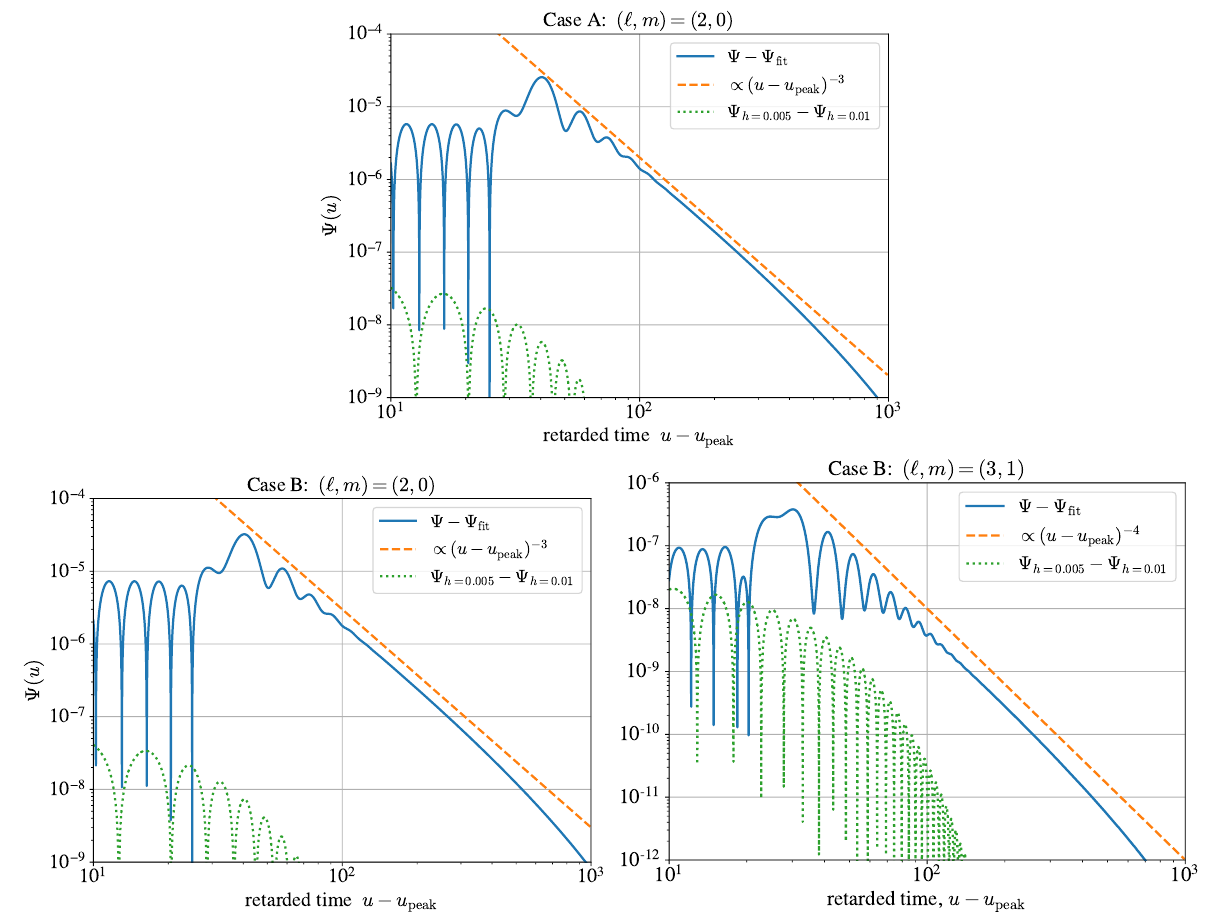
Figure 4. Fit residuals (the blue solid lines) between the Zerilli-Moncrief TD data Ψ (cid:96) m num and the QNM fit including overtones with N = 7. The grouping of panels are the same as for Figure 3. For reference, we plot ∆Ψ in Equation (22) with h 1 = 0.01 M and h 2 = 0.005 M (the green dotted lines) to roughly estimates the numerical error in the data. We also show the lines proportional to ( u − u peak ) − 3 in the ( top ) and ( bottom-left panel) and to ( u − u peak ) − 4 in the ( bottom-right panel) in order to see the late-time behavior (the orange dashed